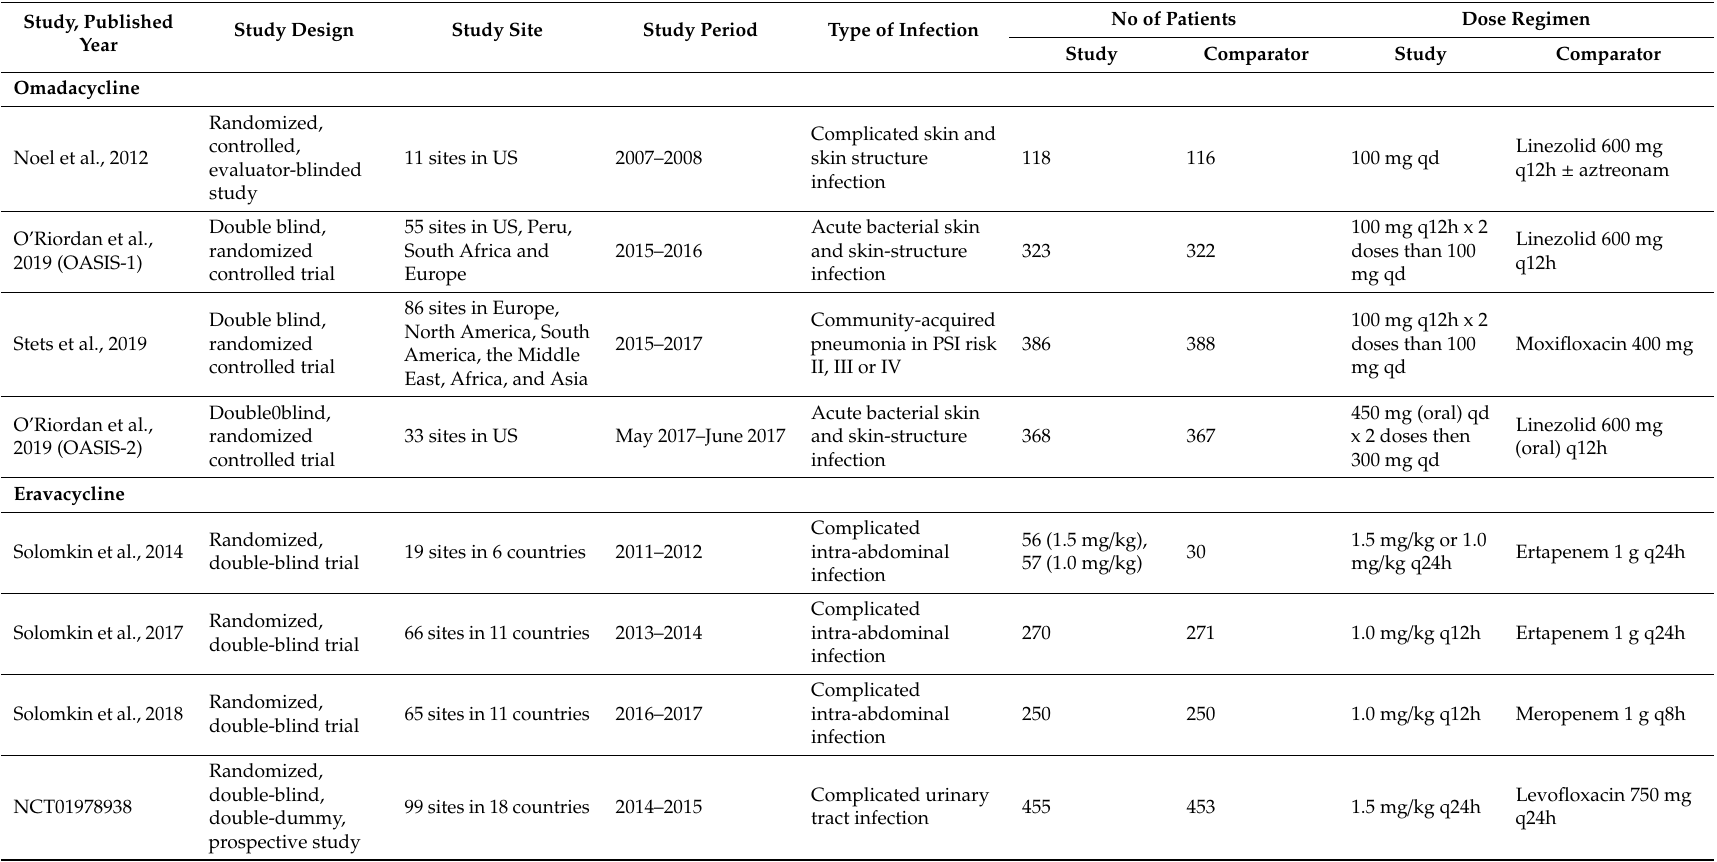
Table 1. Characteristics of included